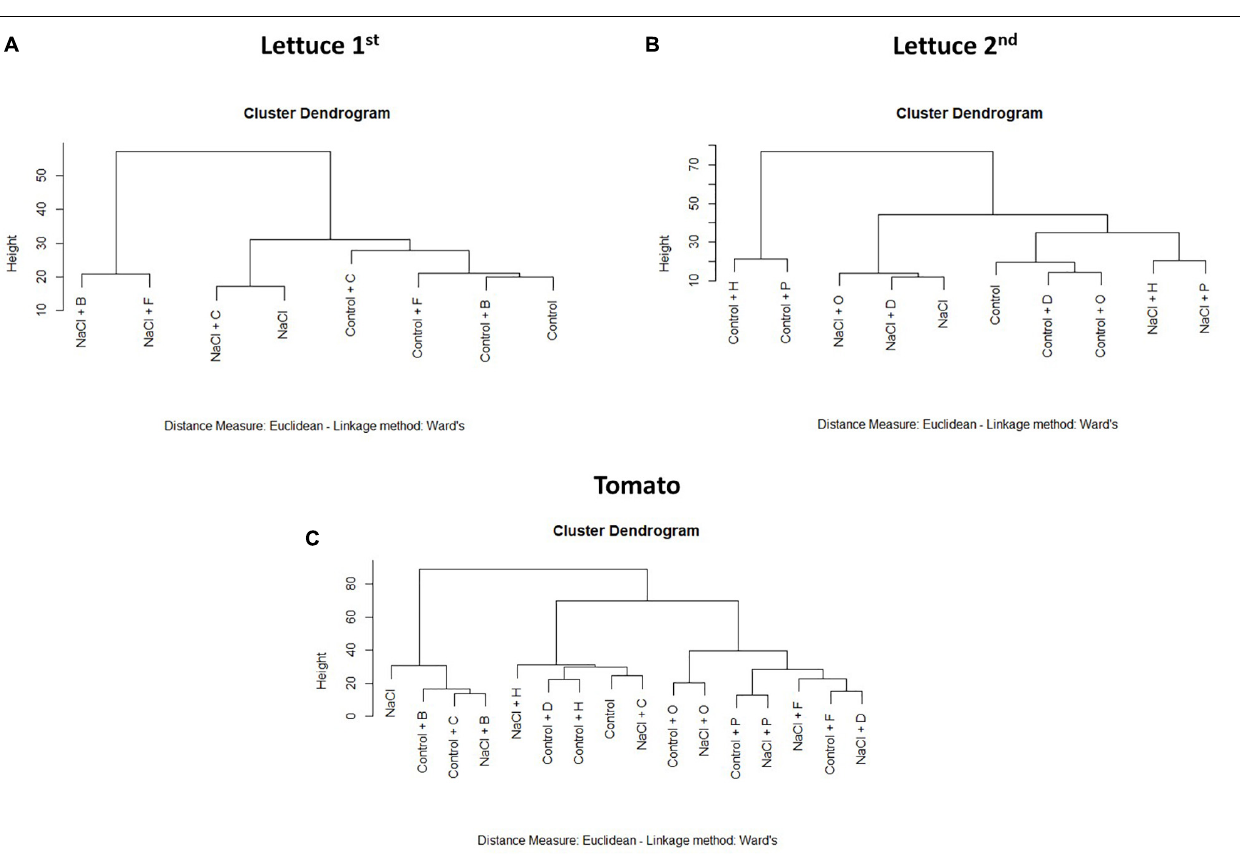
FIGURE 4 | Cluster Dendrograms for all phenotypical data. Cluster analysis of the lettuce [ (A) 1st round and (B) 2nd round] or tomato (C) plants treated with 7 different PHs and grown under control and salt stress